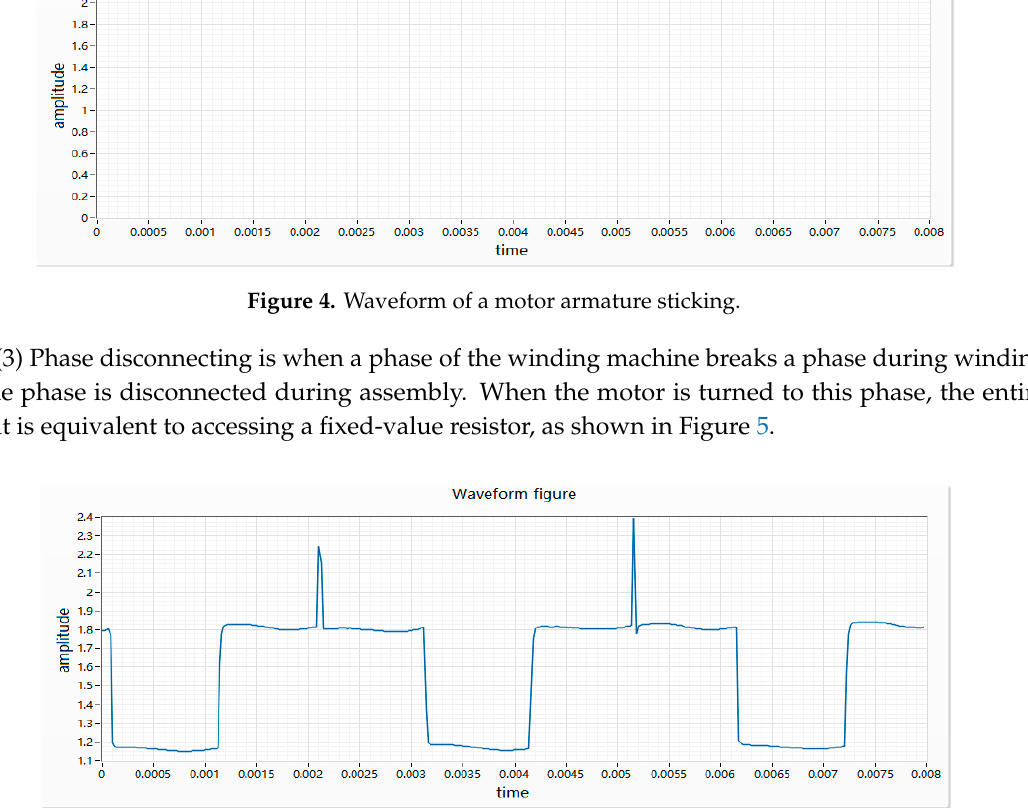
Figure 5. Waveform of phase disconnecting.